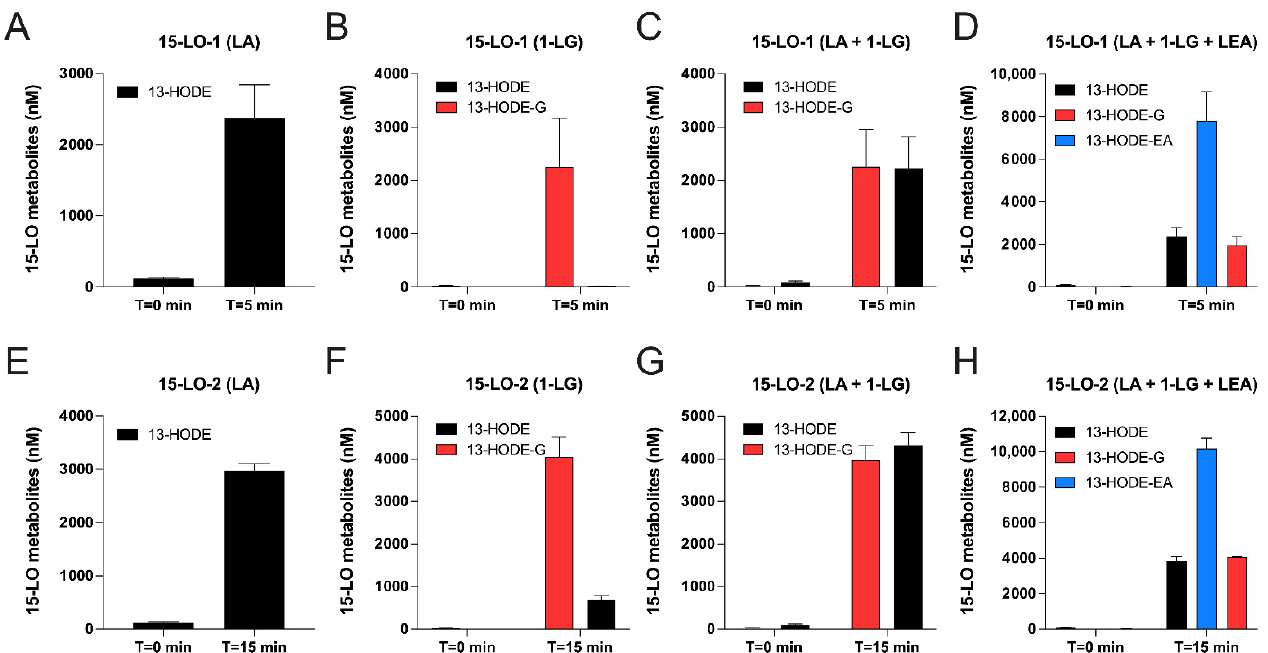
Figure 3. Metabolism of 1-LG, LA and LEA by human recombinant 15-LO-1 and 15-LO-2. Human recombinant 15-LO-1 ( A – D ) or 15-LO-2 ( E – H ) were incubated at 37 °C in HEPES 25 mM containing 0.01% triton. A total of 10 µM of LA ( A , D , E , H ); 1-LG ( B , D , F , H ) or LEA ( D , H ) were added for 5 min (15-LO-1) or 15 min (15-LO-2). NaBH 4 was then added for 5 min and incubations were stopped by the addition of 0.5 mL of cold ( − 20 °C) MeOH containing 0.01% acetic acid and the internal standards. Samples then were processed for LC-MS/MS analyses as described in methods. Results are the mean (± SEM) of 3 independent experiments.